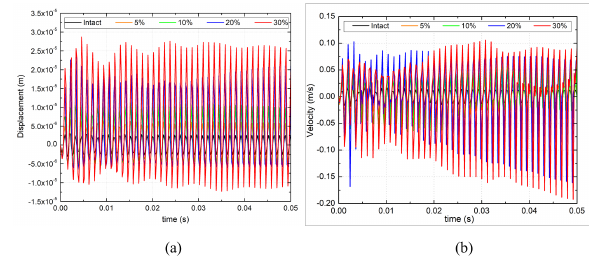
Figure 12: Dynamic response of frequency ratio η =3/4 between intact and debonded models a) displacement b) velocity.